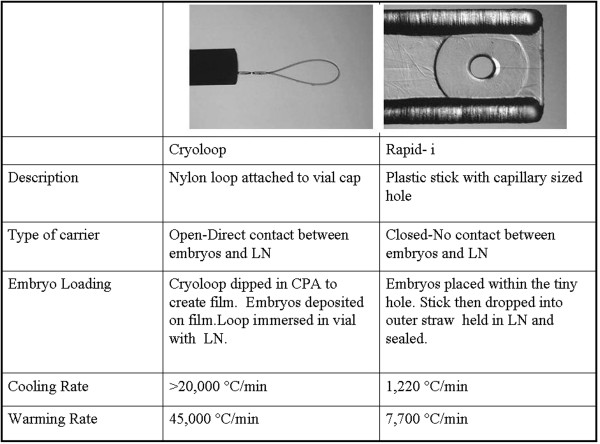
Comparison of the “closed” Rapid-i carrier to the “open” cryoloop. Diagram illustrates the two carriers, properties and compares cooling /warming rates.